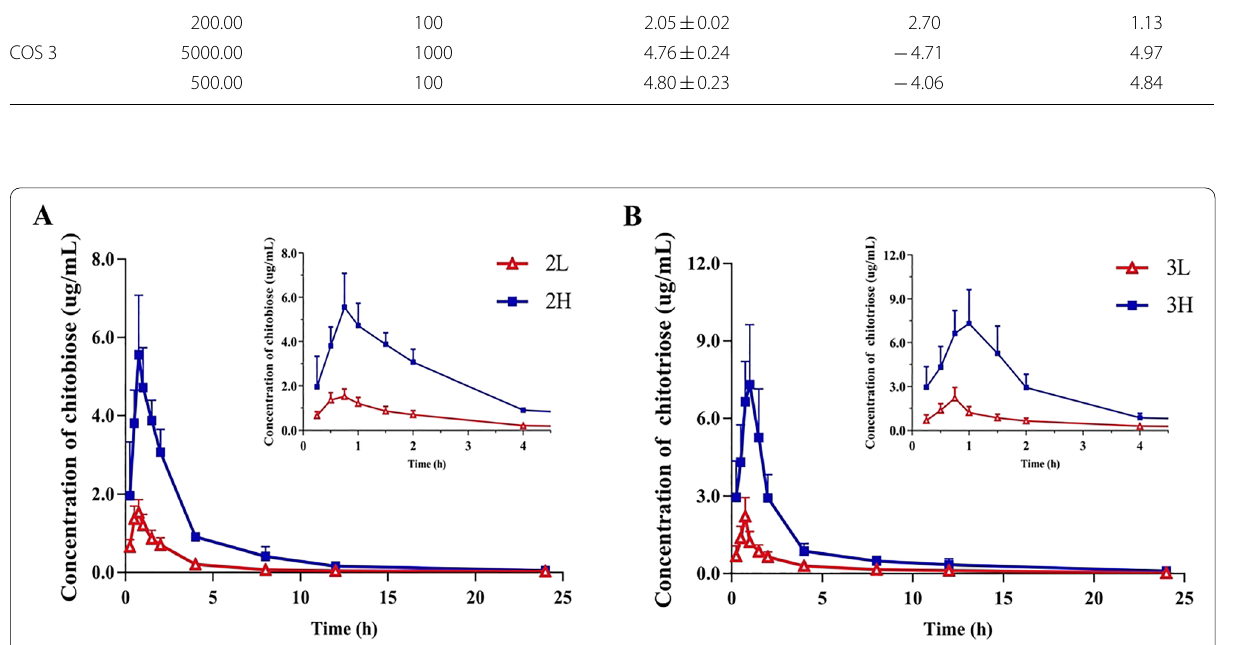
6) vs a withdrawal time after 100 and 500 mg/ =